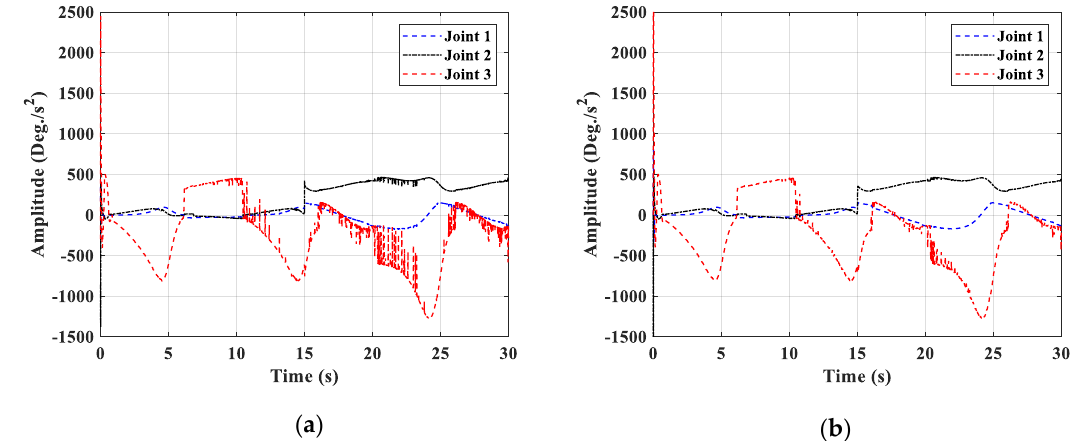
Figure 7. Lumped disturbance response of the planar manipulator at 0.1 Hz: ( a ) lumped disturbance and ( b ) estimated lumped disturbance.